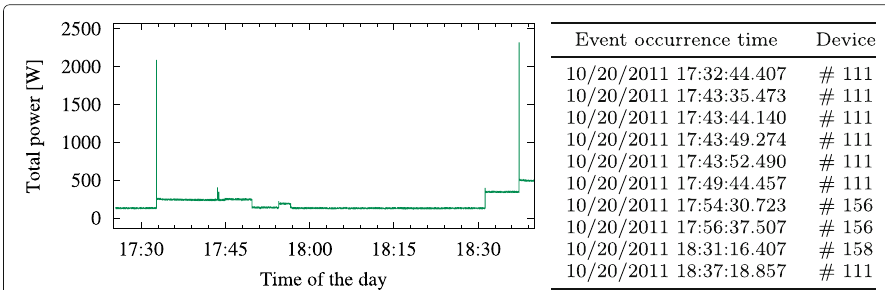
Fig. 1 Excerpt of the BLUED data set, showing the actual data (phase A, collected on 20 October 2011) and the corresponding appliance events from the provided annotations